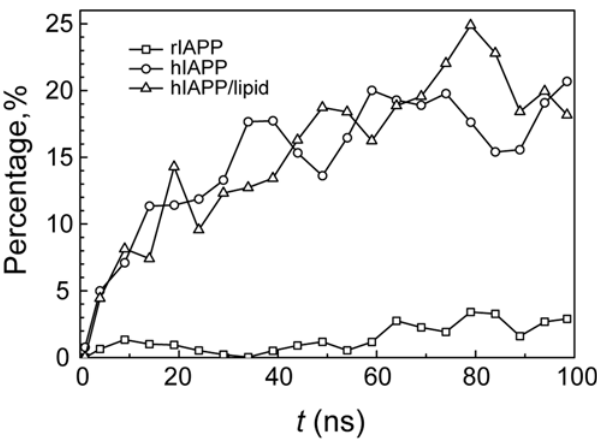
Figure 1. Time evolution of percentages of residues in b -sheet conformation. Residue percentages from all three systems are shown for the lowest-temperature trajectories. The data is averaged every 5 ns.